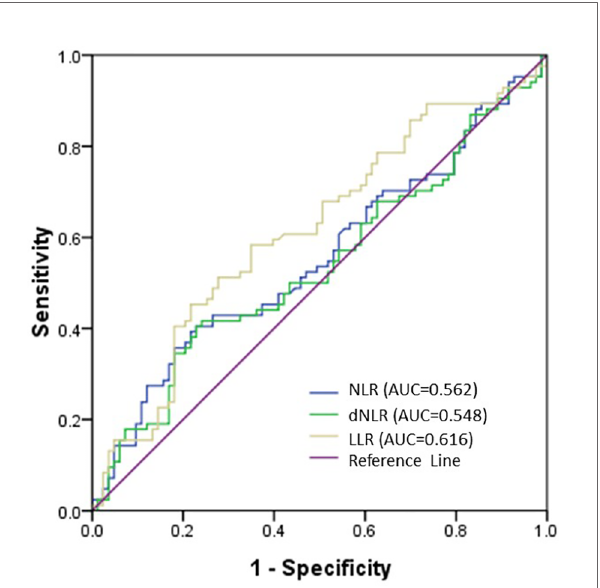
FIGURE 2 | Receiver operating characteristic (ROC) curve of NLR, dNLR and LLR. The area under the ROC curve (AUC) of LLR was 0.616, which was preferable than the NLR (0.562) and dNLR (0.548) AUCs.